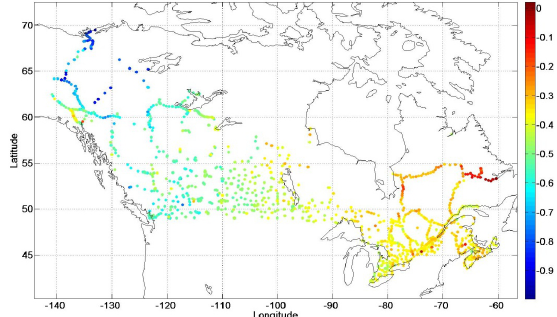
Figure 3. Geoid height differences h - H - N EGM 2008 (in meters) for the CML Nov07 GNSS/levelling benchmarks.